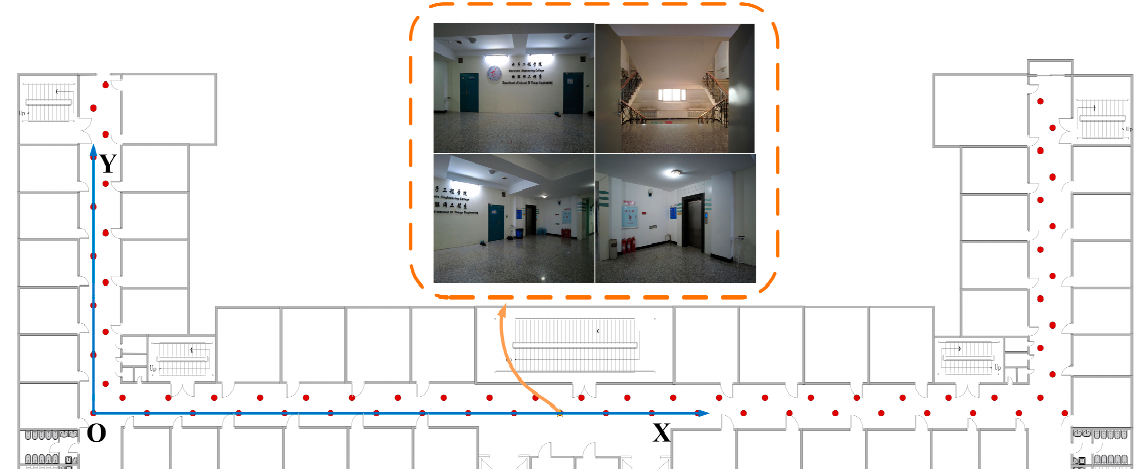
Figure 5. Distribution of sampling points in the electronics laboratory building.